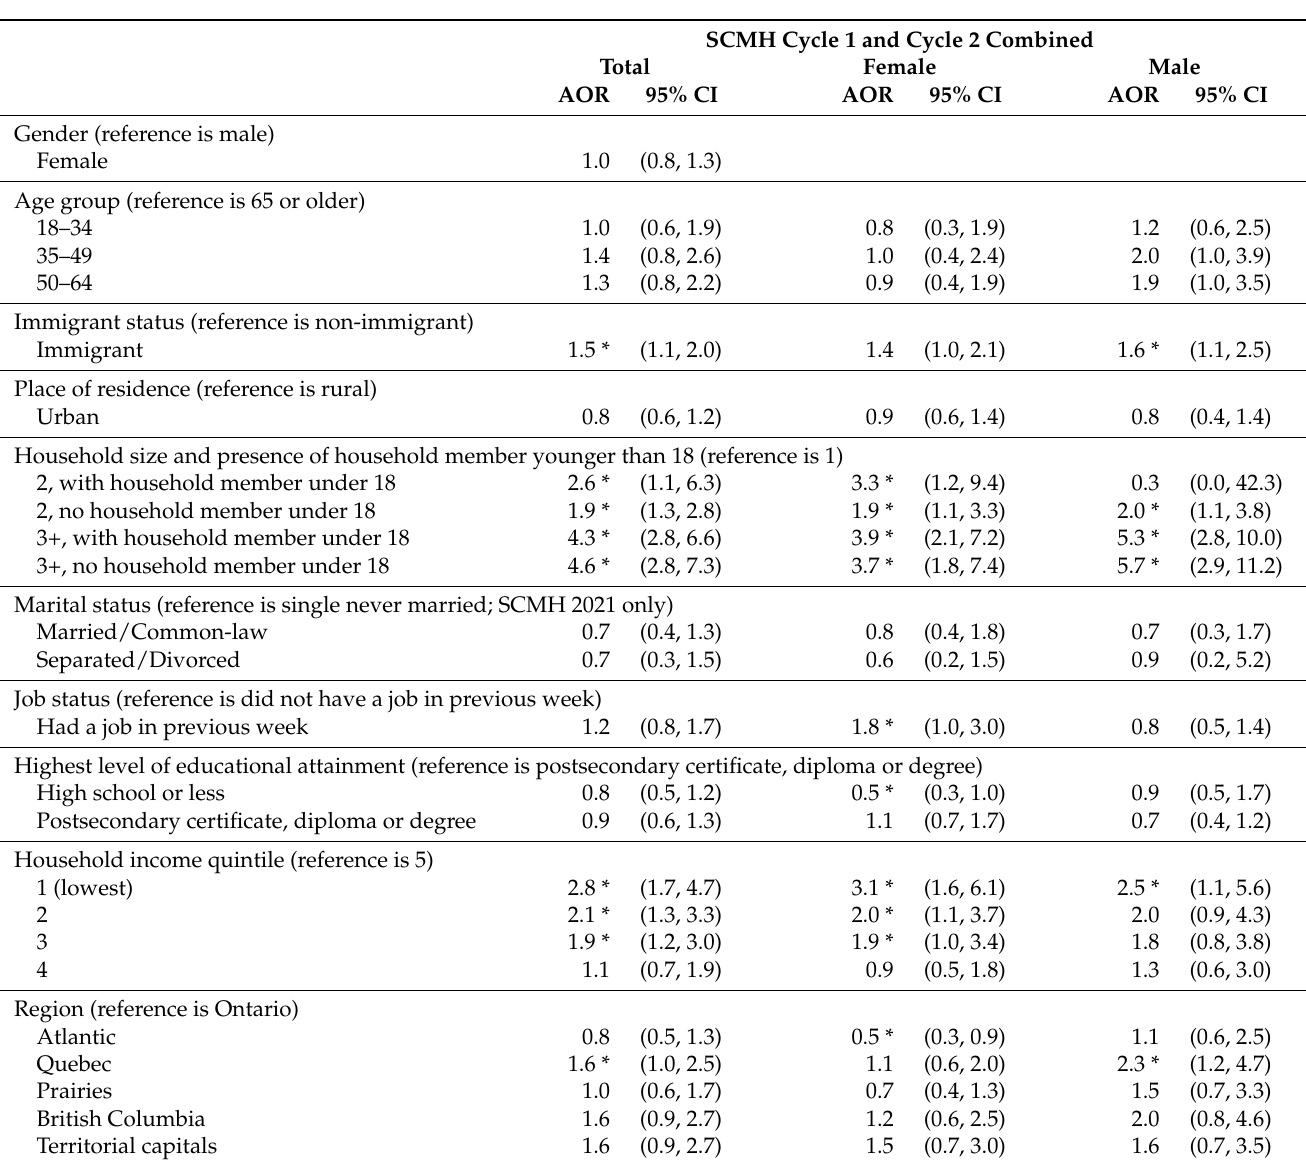
Table 2. Adjusted odds ratios for concern about violence in individuals’ own homes, by gender and sociodemographic characteristics, population aged 18 or older, Canada,